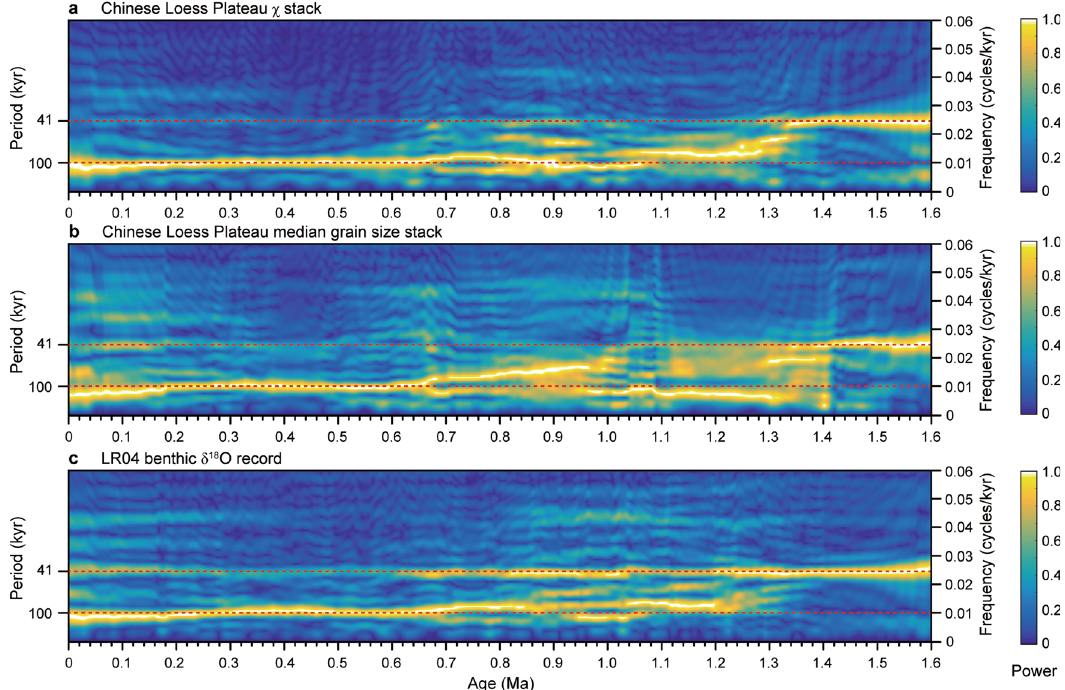
Fig. 5 Orbital-scale climate variability across the mid-Pleistocene transition. Evolutive spectra of the a Chinese Loess Plateau χ stack, b Chinese Loess Plateau median grain size stack, and c LR04 benthic foraminiferal δ 18 O record 47 with a 320-kyr sliding window and 2.6-kyr step. Red dashed lines indicate 41-kyr and 100-kyr